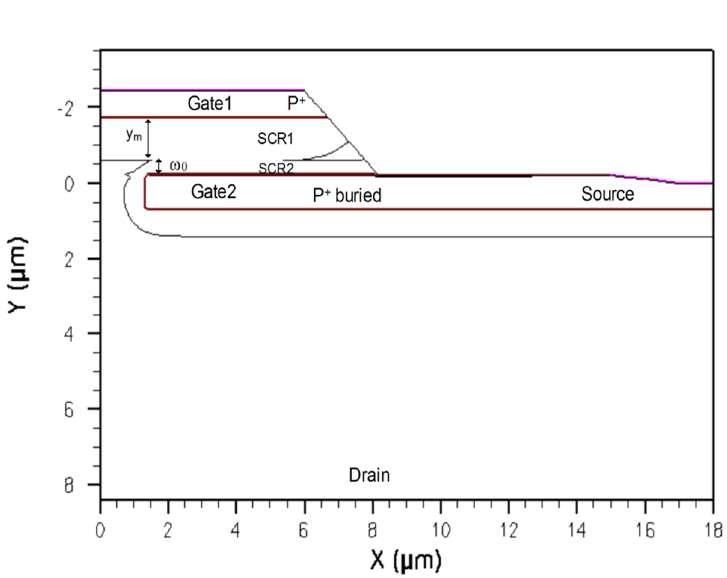
Figure 4. Numerical Solution of 0  function extracted from Figure 3.